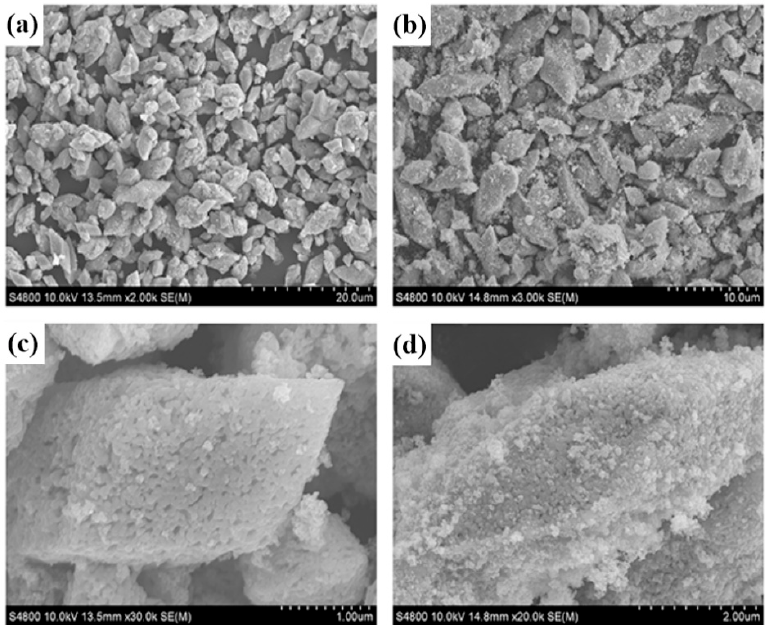
Figure 5. SEM images of ( a , c ) pure phase BST and ( b , d ) BST@ 10 wt% Fe 2 O 3